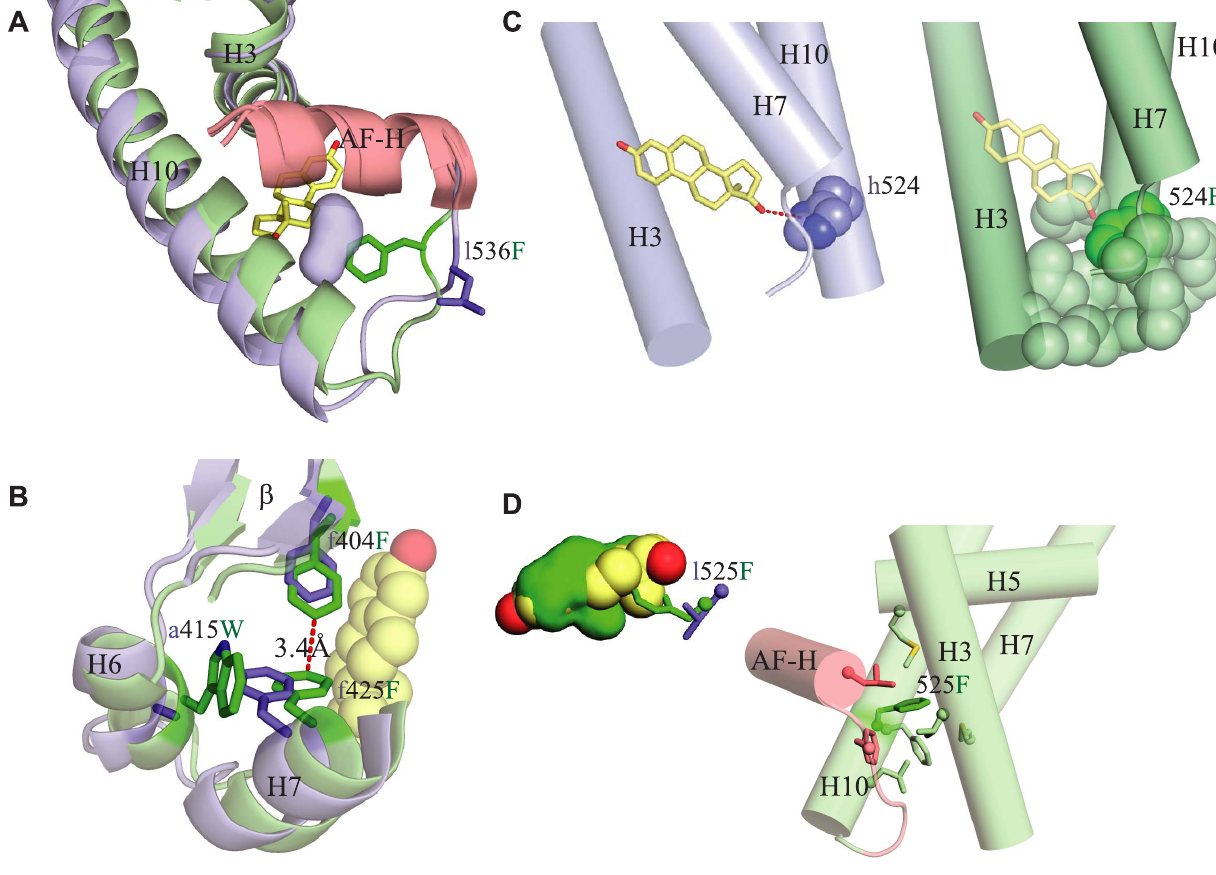
Figure 6. Structural mechanisms by which key mutations contribute to constitutive activity. Each panel shows the CgER crystal structure in green and the AncLophoSR homology modeled structure in blue. Side chains of key residues are shown as sticks; amino acids in AncLophoSR are labeled using lower case letters before the residue number; CgER states are in upper case after the residue number. A. Substitution l536F fills a small secondary cavity in the AncLophoSR (blue surface) just below the AF-H (red), improving packing of AF-H with H3 and H10. B. Substitution a415W pushes neighboring conserved residue F425 into the ligand cavity, where it packs against F404 and stabilizes the interactions of H6, H7 and the b - sheet. C. h524F abolishes a hydrogen bond (red dotted line) to estradiol (yellow) in AncLophoSR. In CgER, the aromatic residue F524 (dark green spheres) packs against several amino acids on H3, H7 and H10 (light green spheres), forming a bridge across the bottom of the pocket. D. Substitution l525F occludes the ligand pocket. Left panel: bulky residue F525 occludes the ligand cavity (green) and would clash directly with estradiol (yellow). Right panel: F525 (dark green sticks) also makes van der Waals contacts to numerous residues (light colored sticks), connecting H10 to H3, H5, H7, and